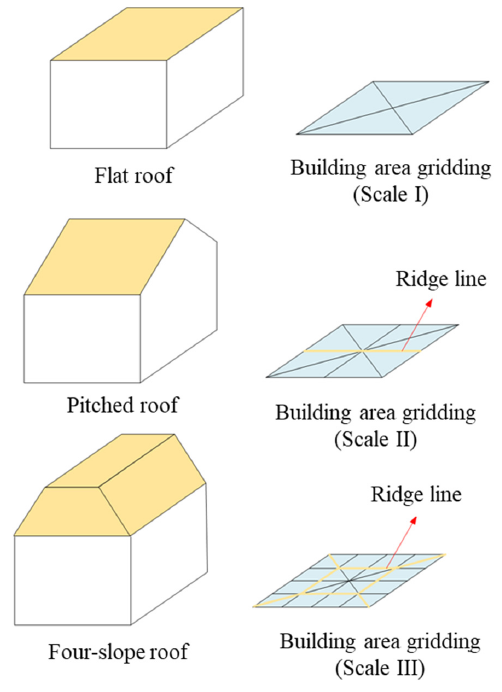
Figure 3. Multiscale gridding of building